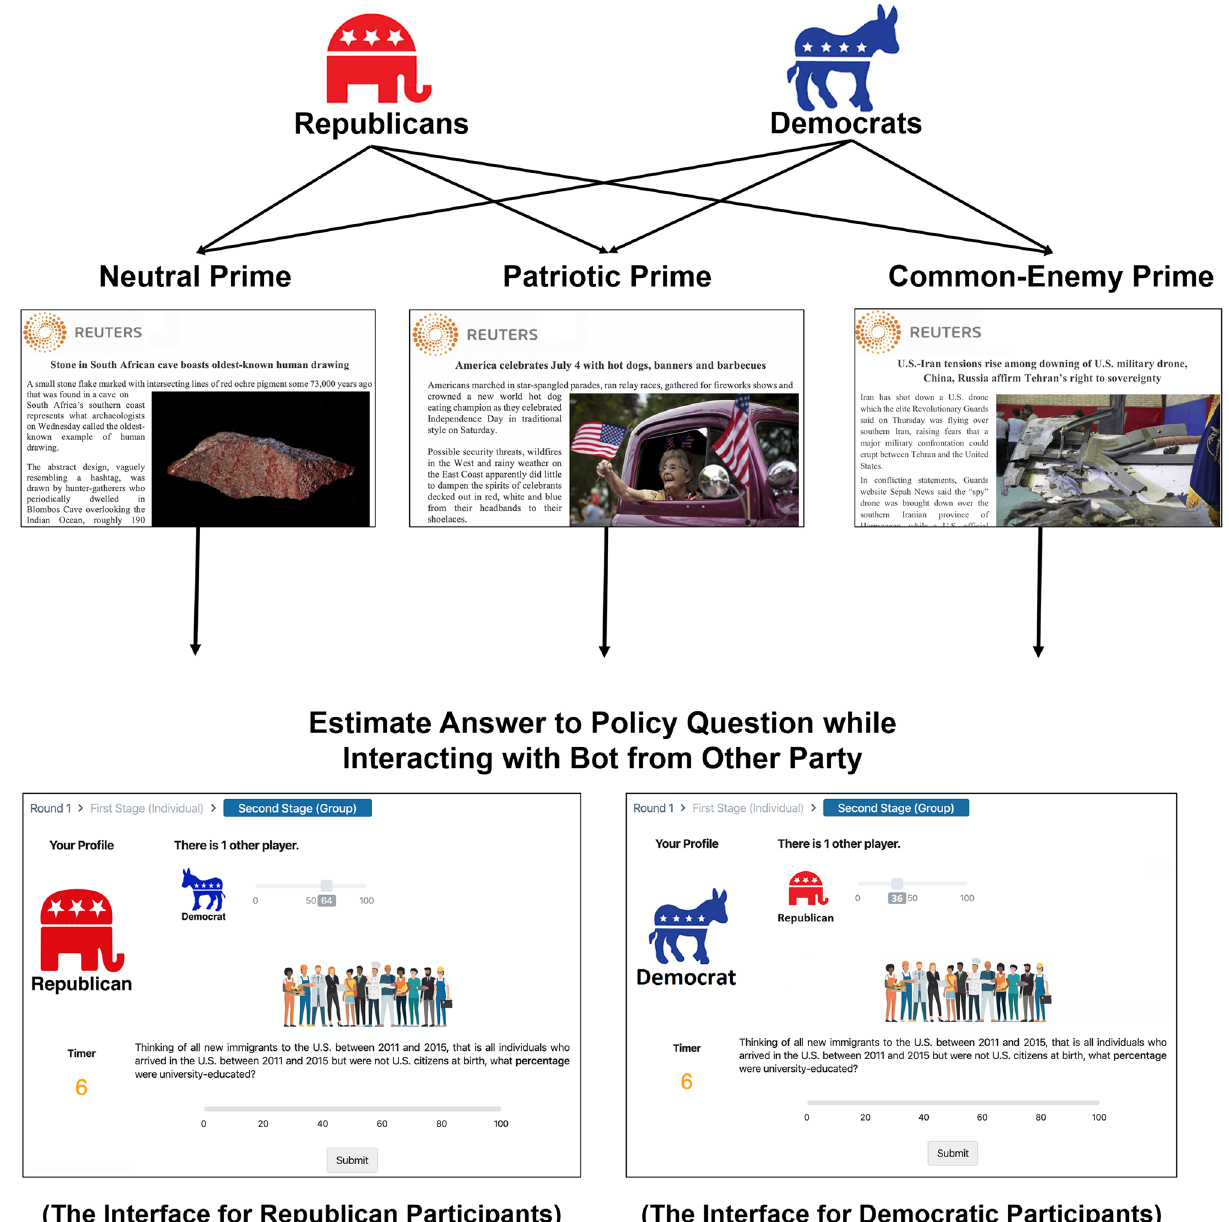
Figure 1. Schematic illustrating the experimental design. 1670 Republicans and Democrats were randomized into one of three experimental conditions: (1) the neutral prime condition, where they read an article about early human carvings in South Africa; (2) a patriotic prime condition, where they read an article about Fourth of July celebrations; and (3) a common-enemy prime condition, where they read an article about the combined threat of Iran, China, and Russia. After reading the article, each participant was offered financial incentives to estimate the answer to a question about a political issue and told that their compensation would increase according to the accuracy of their response. After submitting their first estimate, participants were shown the estimate of a bot impersonating a member of the opposing party. By measuring how often members of each party revise their answers towards the bot in the subsequent round of estimation, we measure how much members of each party learn from the opposing party within each treatment